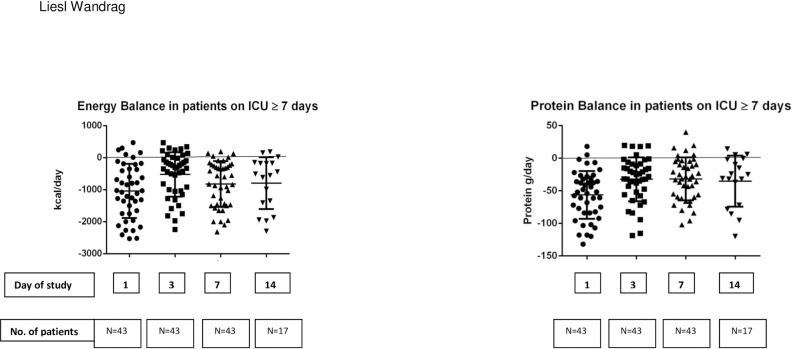
Predicted energy and protein balance of patients on the unit for ≥7 days (N = 43) over 14 days.